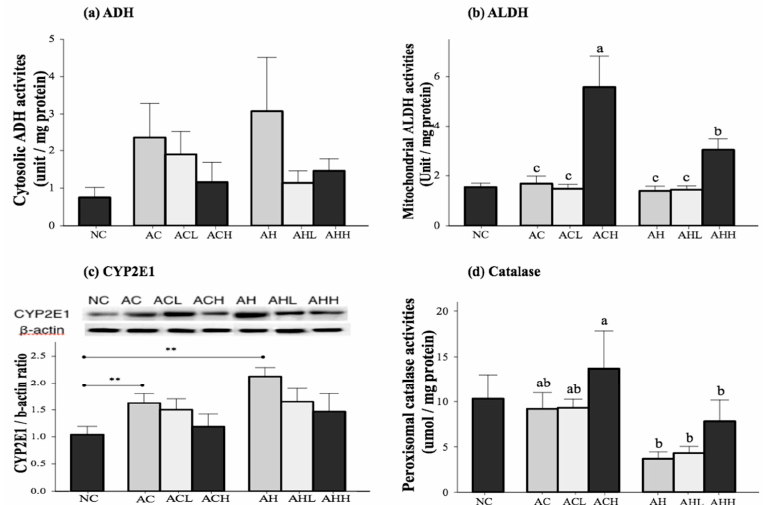
Figure 3. Effects of AK on alcohol metabolism in C57BL/6J mice fed with alcohol and HFD: ( a ) ADH; ( b ) ALDH; ( c ) CYP2E1; and ( d ) Catalase. Each value is expressed as the mean ± S.E. NC, normal control;